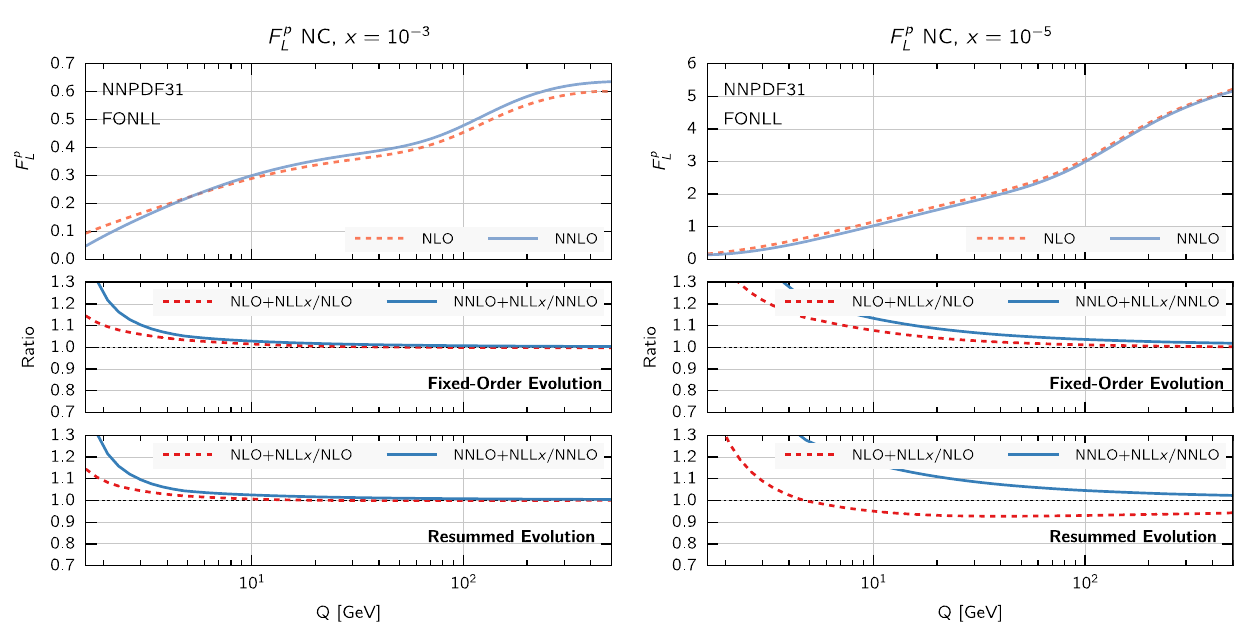
( x , Q ) , the charm component of the structure function F 2